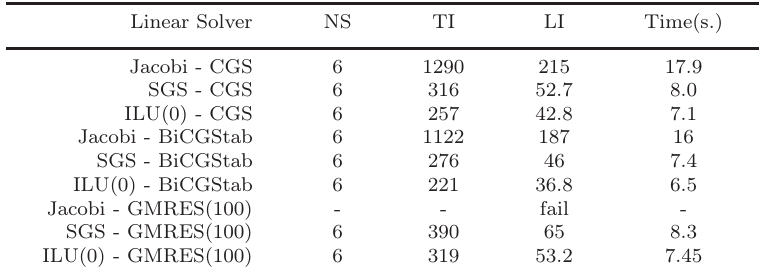
Table 2. Comparison of linear solvers and preconditioners. Linear Solver NS